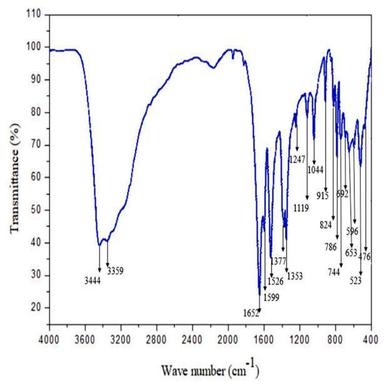
G4C3NBM crystal's FTIR spectrum.